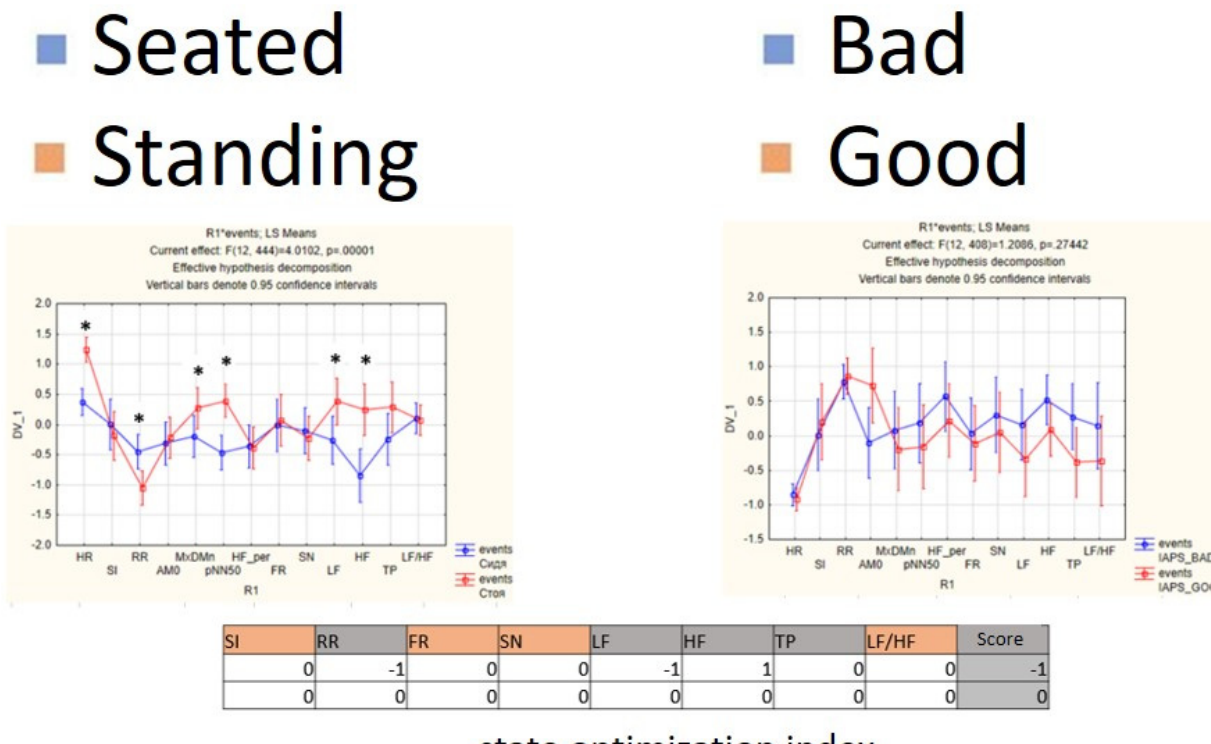
Figure 22. An example of a calm state of a test subject, the Basic complex.